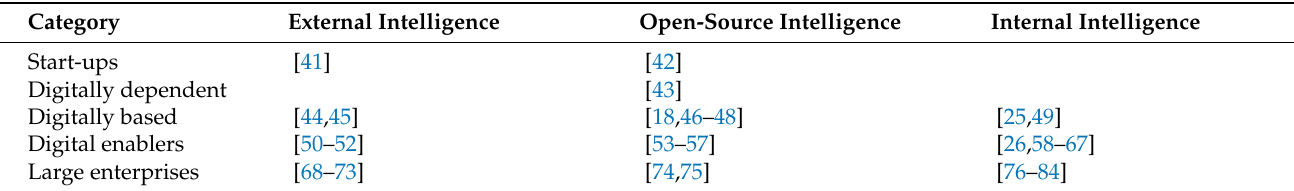
Table 2. The type of cyber threat intelligence used in each of our 47 inclusions, along with the minimum SME category maturity required to implement the proposed